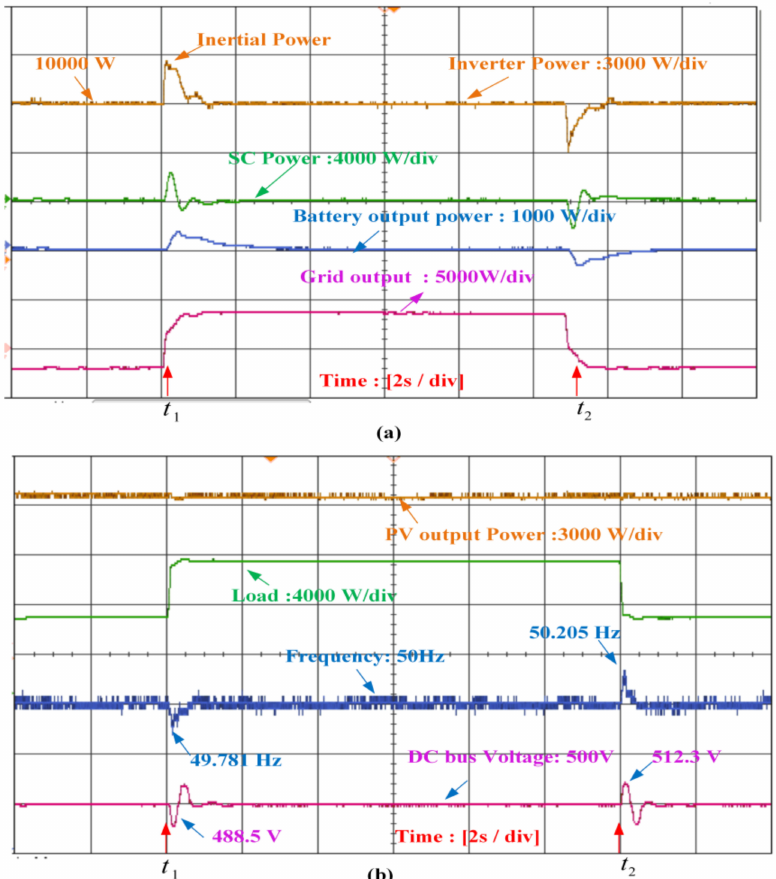
Figure 17. ( a ) Load variations for constant irradiation ( a ) power from inverter, SC, battery, and grid; ( b ) PV Power, load, frequency, and DC bus